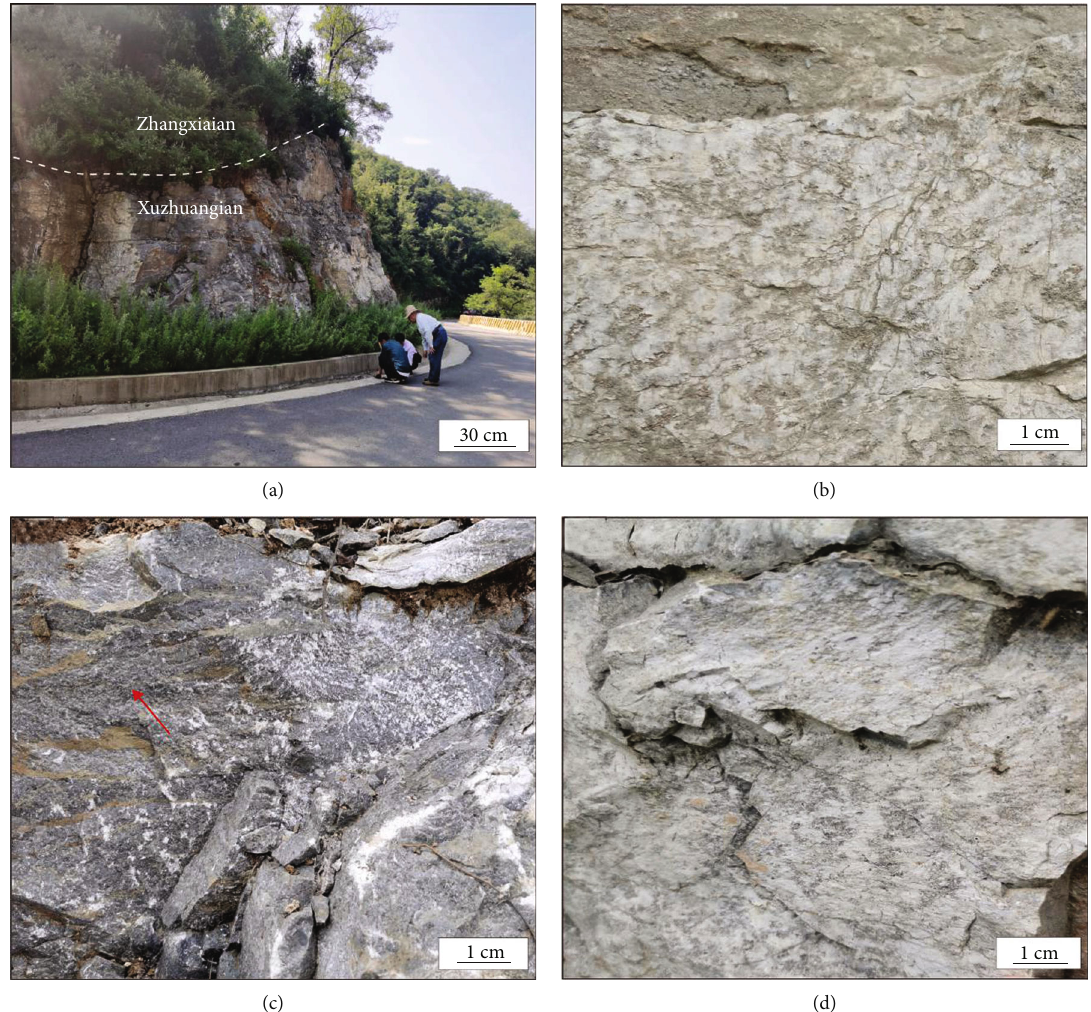
Figure 3: Macroscopic characteristics of Houziyu Section in Ezhuang Town, Zibo, Shandong Province. (a) The boundary between the Zhangxia Formation and Xuzhuang Formation (as shown by white curve). (b) The centimeter-scale shrubby fabric in the dendrolites of Zhangxia Formation is partly replaced by yellow calcareous mudstone. (c) The oolitic limestone of the Xuzhuang Formation develops scouring surface (as shown by red arrow). (d) Shrubby fabric composed of dark argillaceous crystals in dendrolites of Zhangxia